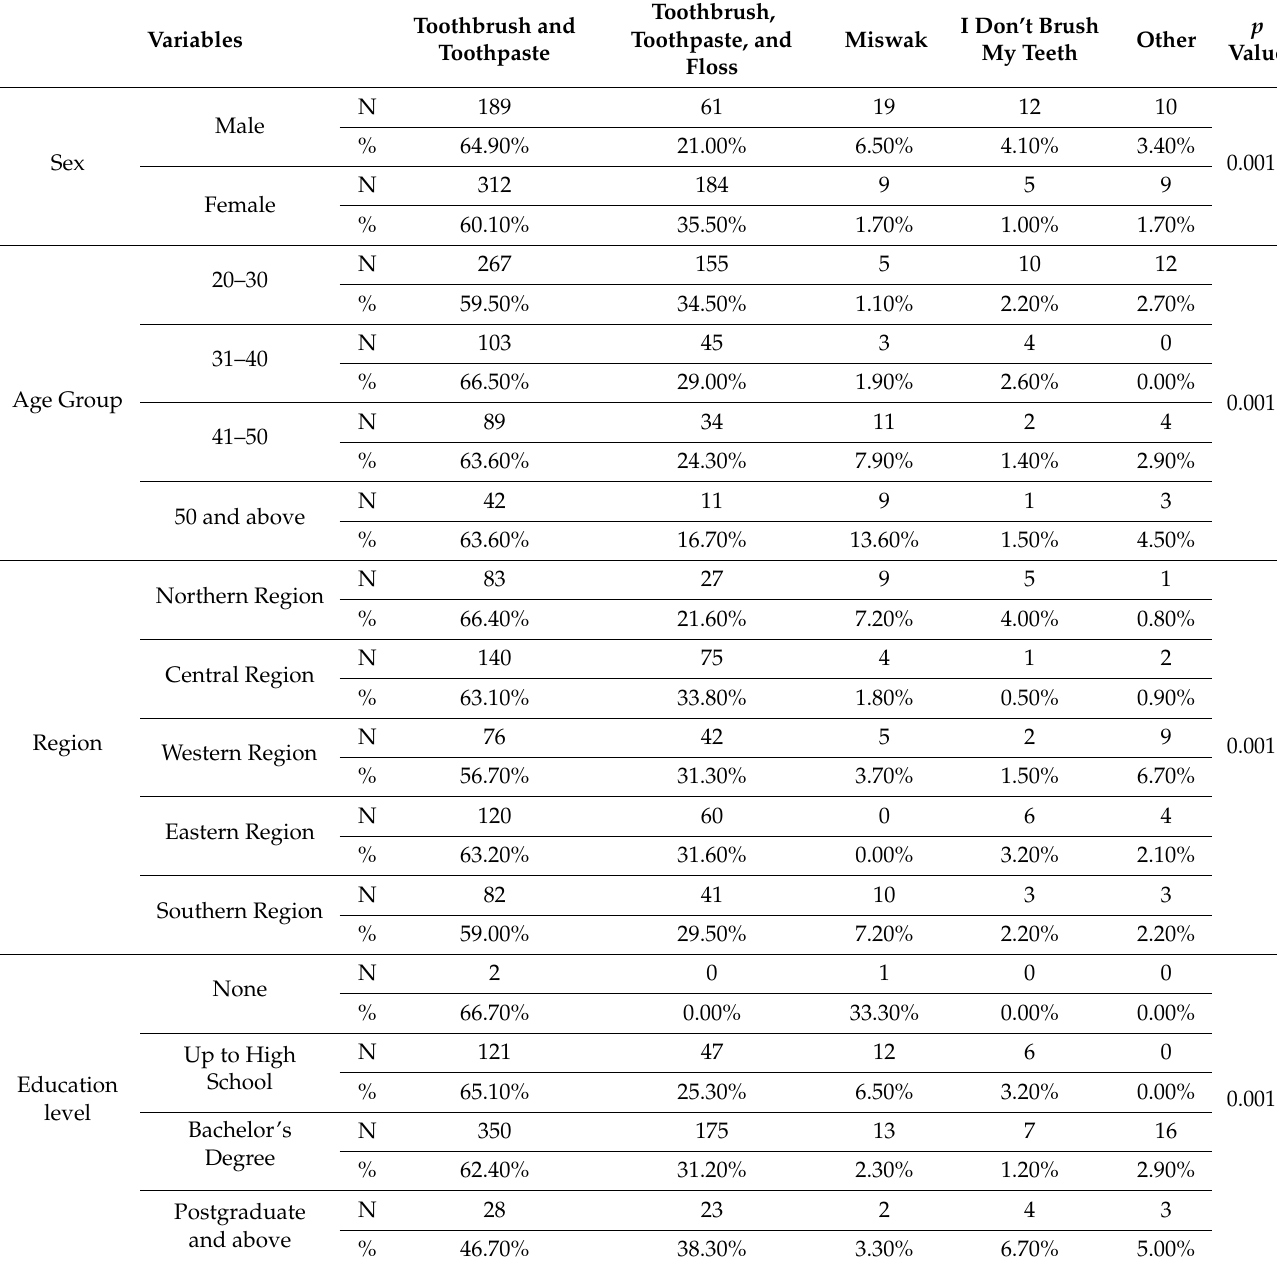
Table 2. Perception and knowledge of different parameters on “What do you use to clean your